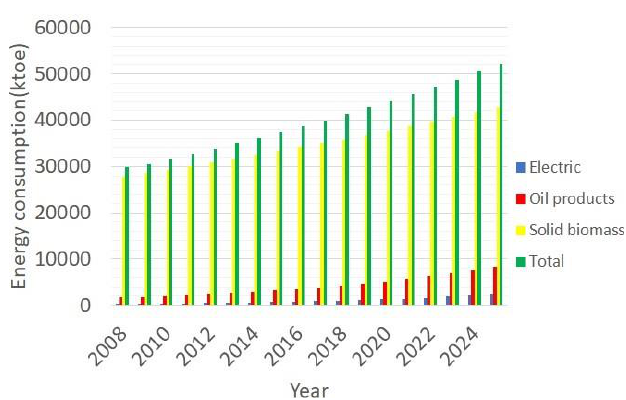
Fig. 5. Ethiopian energy consumption